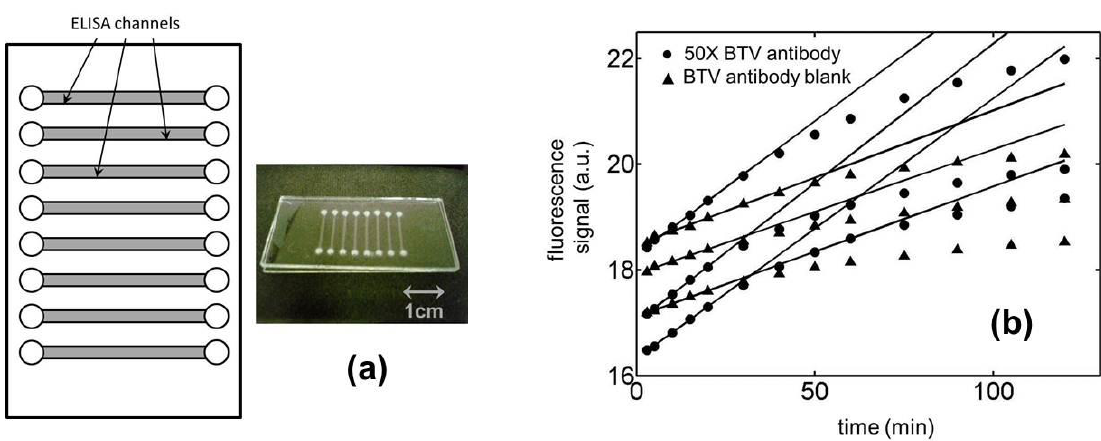
Figure 1. ( a ) Microchip design used in the present study. ( b ) Temporal variation in the fluorescence signal in microchannels with an active ELISA surface for 50× BTV antibody samples and its corresponding blanks. The presented data set are for 3 repetitions of each of these ELISAs in separate fluidic ducts. Although in this particular case, all of